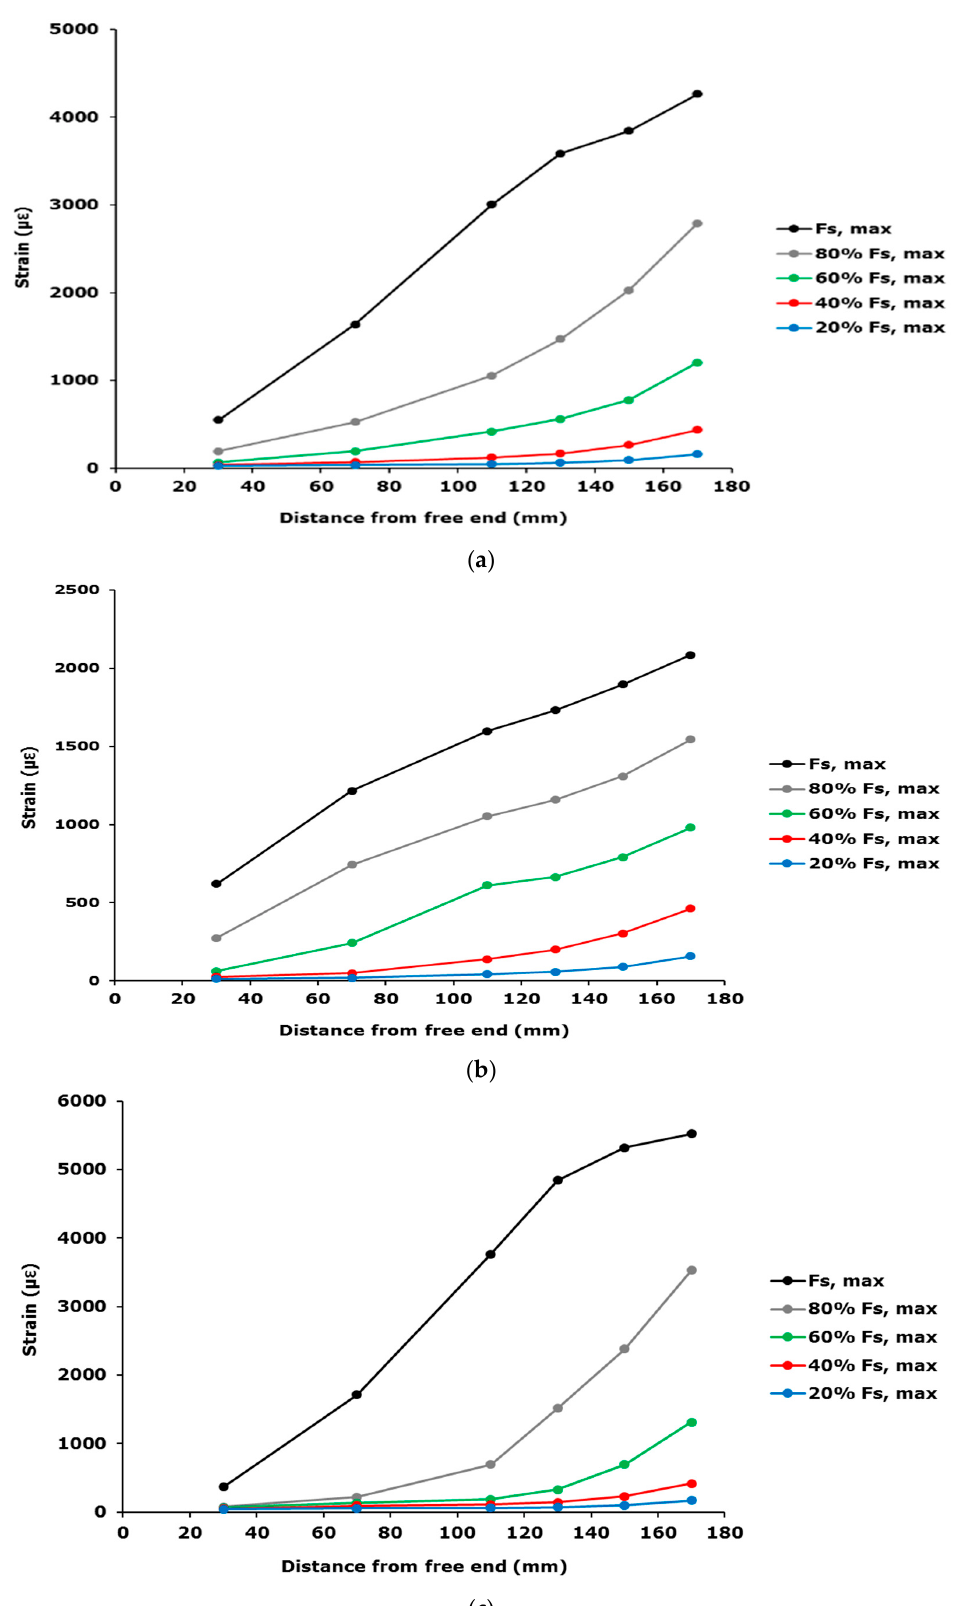
Figure 4. ( a ) IHSSC-CA–SG; ( b ) PCA–SG; ( c ) EA-SG.